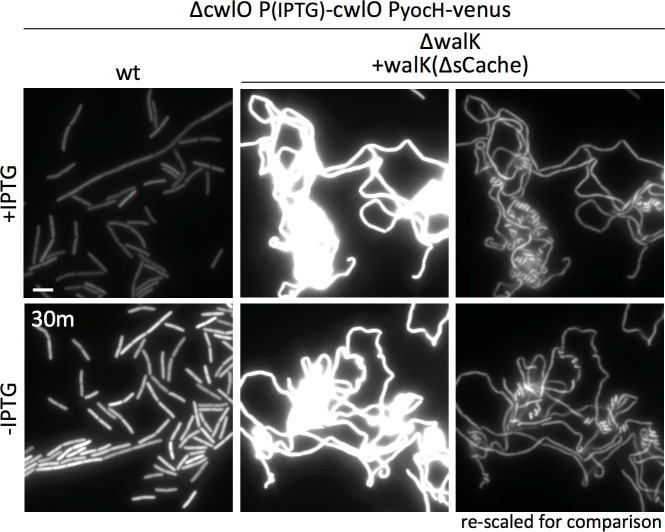
Deletion of the extracellular sCache domain of WalK renders the sensor kinase unresponsive to depletion of CwlO.Representative fluorescence images of strains harboring the PyocH-venus reporter and a ∆cwlO mutation complemented by an IPTG-regulated allele of cwlO. A strain with an intact walRK locus (wt) was compared to one lacking native walK and expressing a WalK variant deleted for its extracellular sensory domain (WalKΔsCache). Cells were grown to OD600 ~0.3 in LB medium supplemented with 1 mM IPTG, washed in medium lacking inducer, and imaged before (+IPTG) and 30 min after inoculation in LB medium lacking inducer (-IPTG). The fluorescent signals in the WalK∆sCache strain before and after CwlO depletion were re-scaled to allow direct comparison on the right. Scale bar indicates 5 µm.